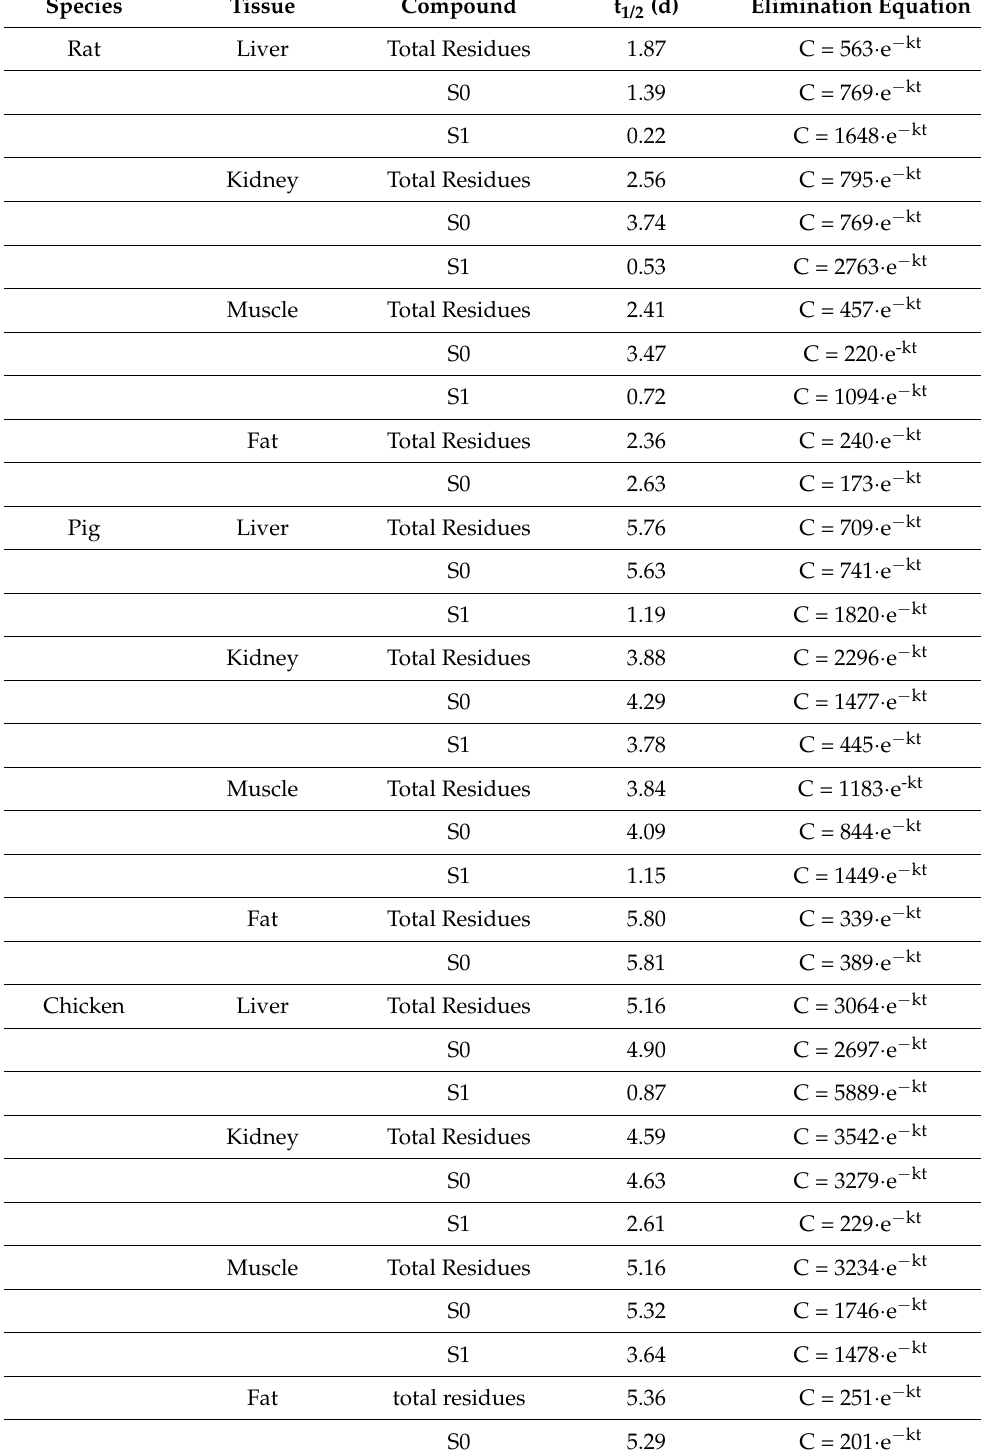
Table 6. Summary of the elimination parameters of the total radioactivity and major metabolites in the tissues of pigs, chickens and